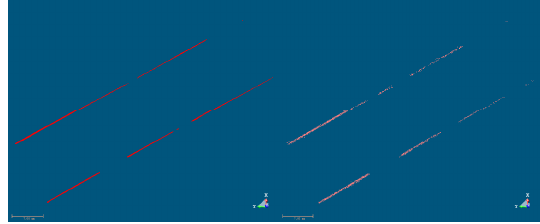
Figure 15. The road curb of Dalhousie St. Left: truth data. Right: the extracted.